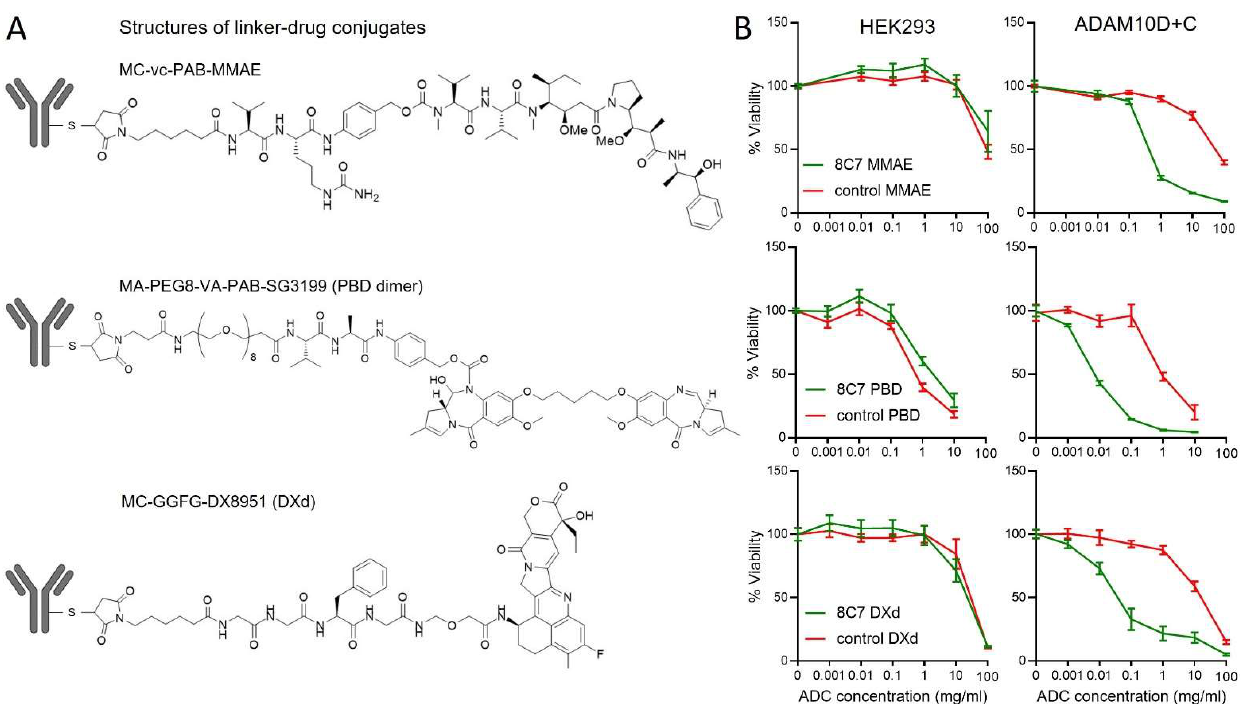
Figure 4. 8C7-ADCs specifically kill cells expressing ADAM10 with the exposed C domain epitope. ( A ) Structures of drugs (MMAE, PBD or DXd) and linkers conjugated to 8C7 and control IgG. ( B ) Cell viability of HEK293 cells expressing an ADAM10 construct lacking the metalloprotease domain (ADAM10D + C), or parental HEK293 cells, after treatment with the indicated doses of 8C7 ADCs or matched control IgG ADCs. Cell viability was tested after 3 days by MTS assay. Graphs show mean +/− SEM ( n ≥ 4).